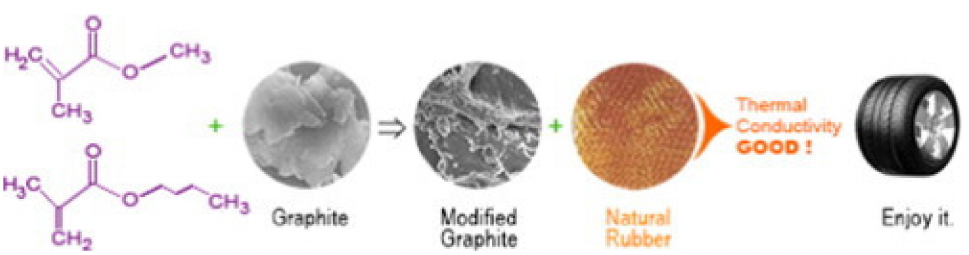
Figure 5. Scheme of the graphite’s modification with polyacrylates and introduction into NR for the generation of rubber composites for tire applications [148]. Copyright © 2021 Elsevier B.V. All rights reserved.